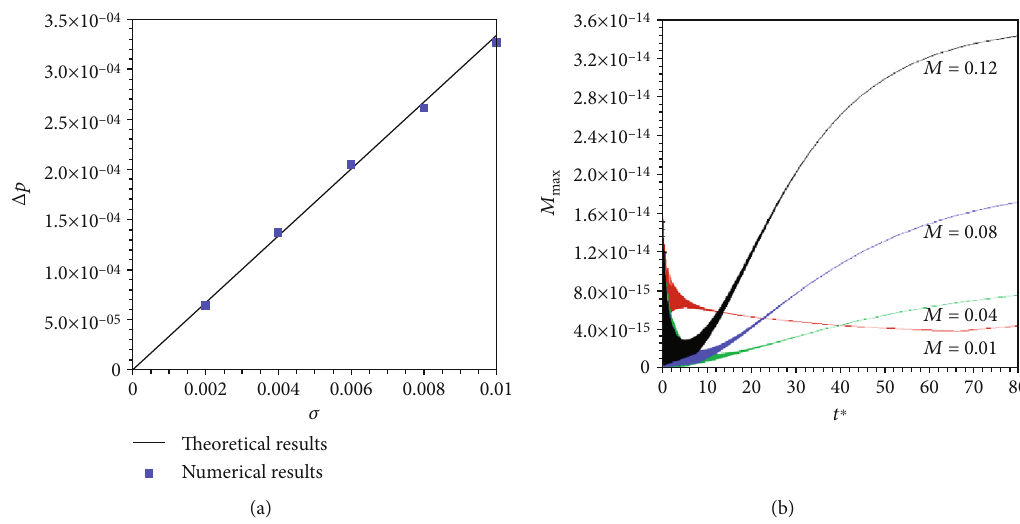
Figure 1: Validation and sensitivity study. (a) Comparison of the pressure di ff erence between theoretical and numerical results. (b) Maximum kinetic energy for various